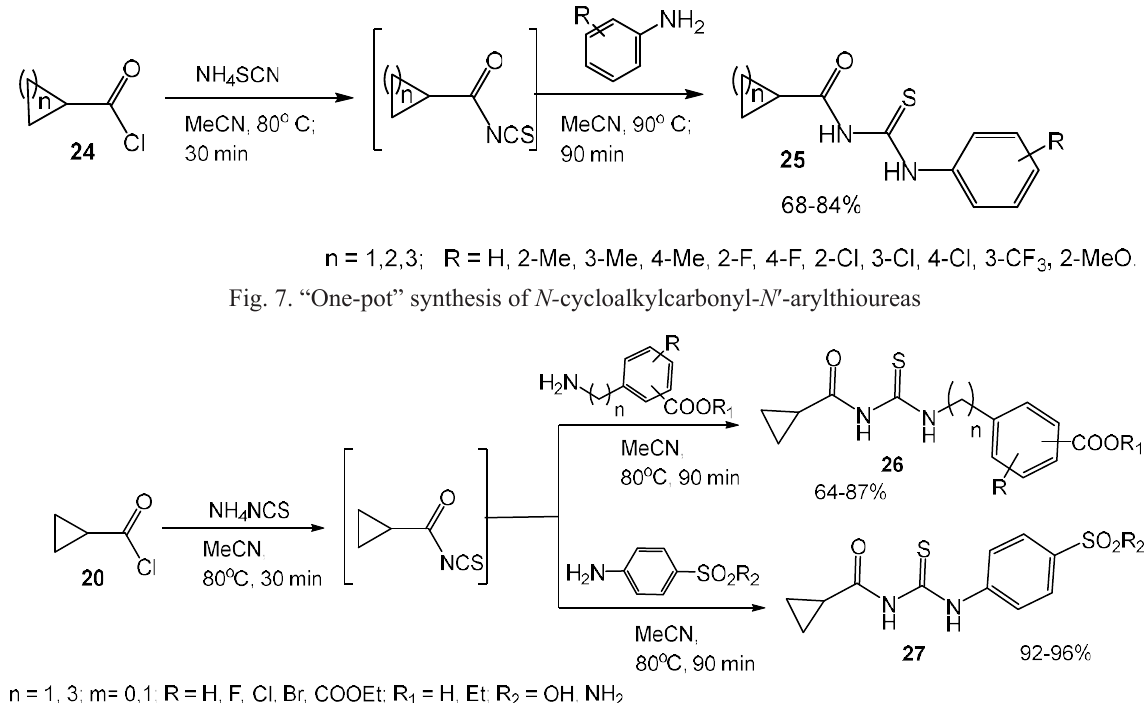
Fig. 8. Approaches to the synthesis of substituted N-